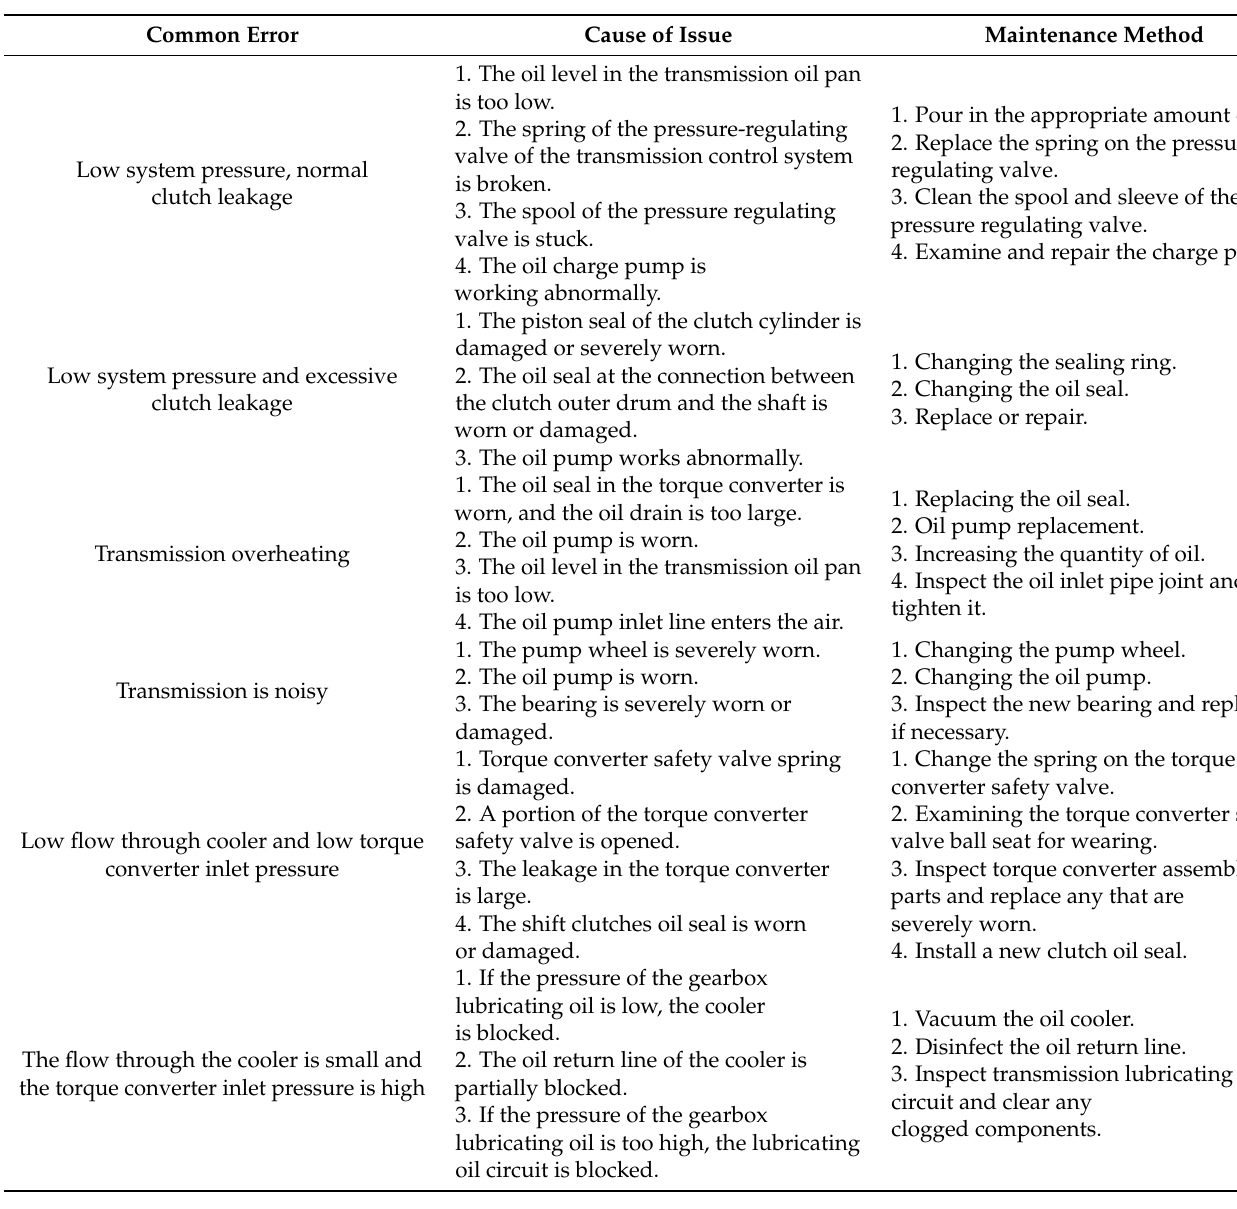
Table 2. Power shift wet clutch common fault and